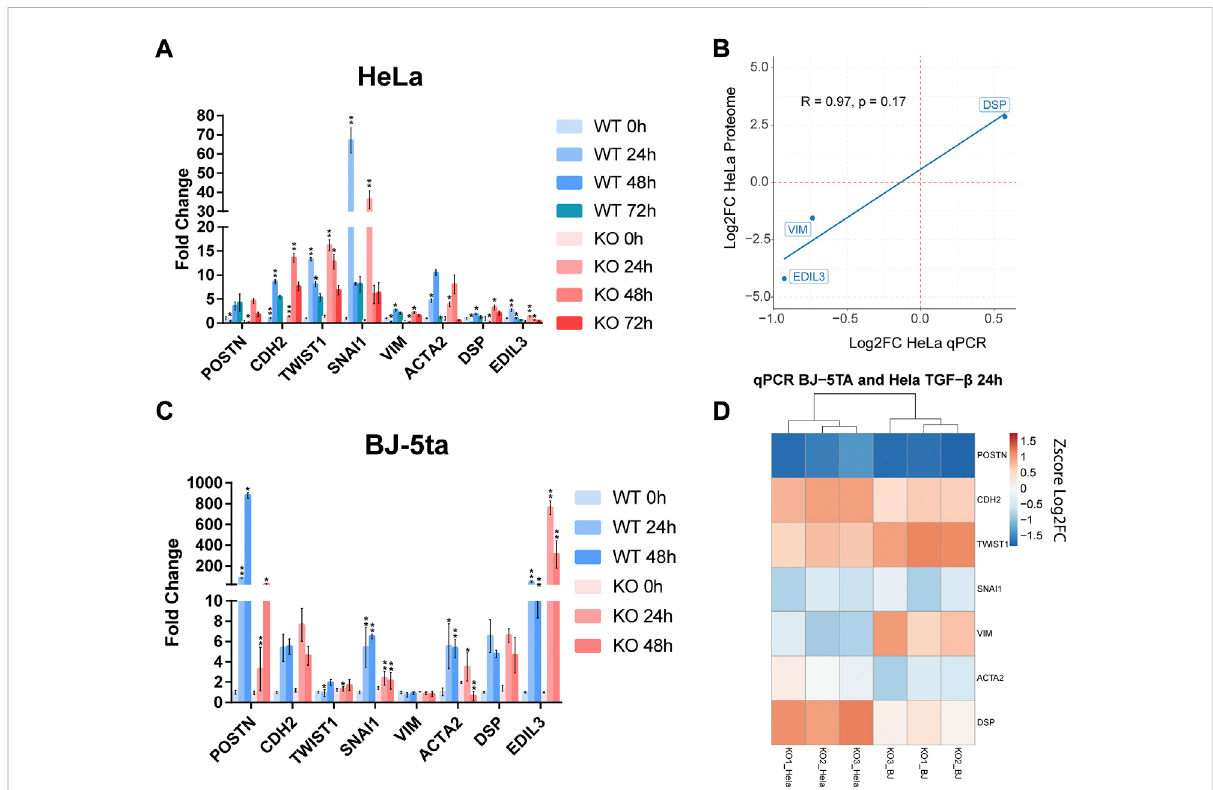
FIGURE 5 Expression measurement by qPCR of different EMT biomarkers with TGF- β stimulation at (A) 0, 24, 48, and 72 h in HeLa. (B) Correlation plot between the expression of three EMT markers in the HeLa proteomic analysis and the HeLa qPCR assay. The expression is represented based on the log2 FC and the R coef fi cient using Pearson ’ s method. (C) Expression measurement of EMT markers by qPCR in BJ-5ta after 0, 24 and 48 h of stimulationwithTGF- β 1ligand (D) ComparativeheatmapwithZ-scorevaluespersampleofEMTmarkersinHeLaandBJ-5taafter24 hofTGF- β 1 stimulation. These experiments were performed by triplicate ( n = 3). *: adj. p -value < 0.05, **: adj. p -value <